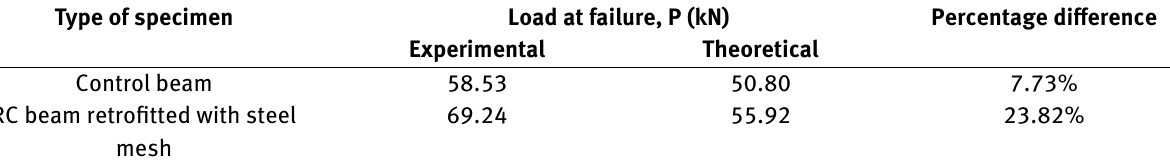
Table 5: Comparision between experimental and theoretical values.